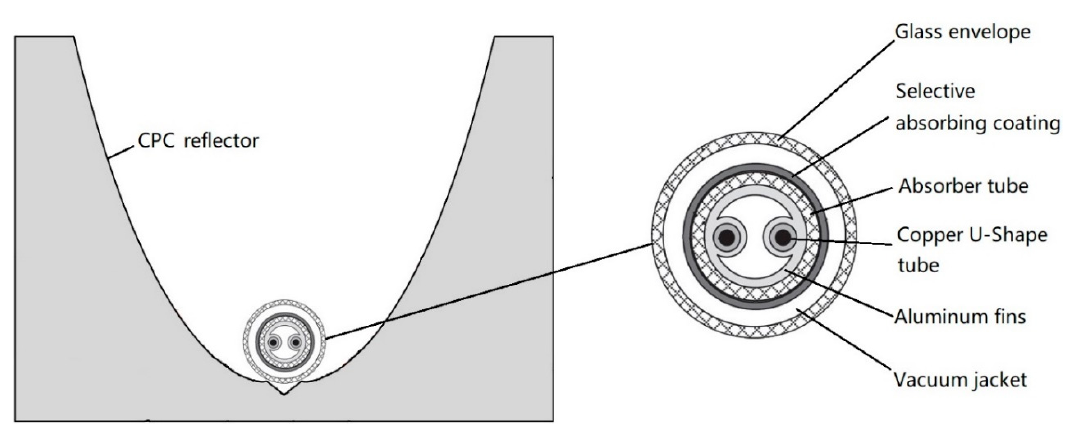
Figure 20. External concentrating CPC with U-shaped pipe [49].